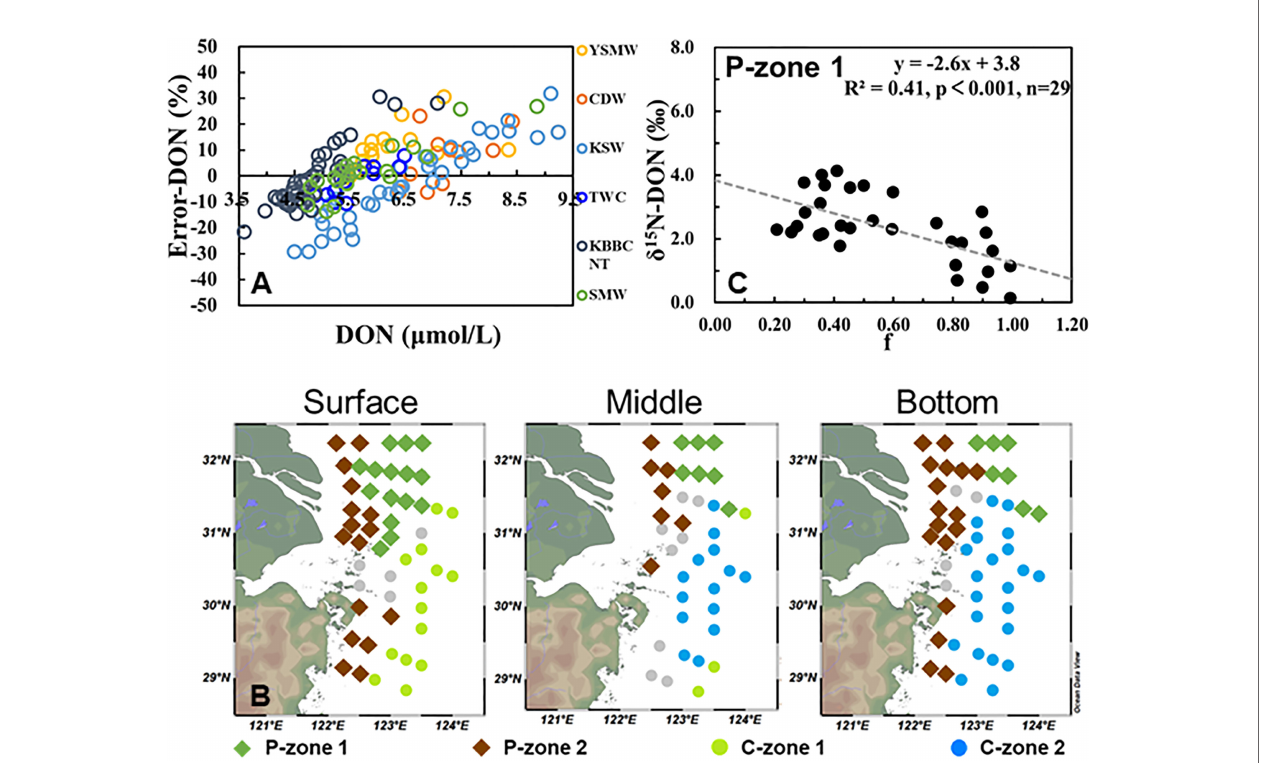
FIGURE 6 | (A) Scatter plots showing the difference (in percentage) between the observed and calculated values of dissolved organic nitrogen (DON) vs. the observed DON concentration. Different colors are used to distinguish stations where Yellow Sea Mixed Water, Changjiang Diluted Water, Taiwan Warm Current, Kuroshio Surface Water, or Kuroshio Bottom Branch Current North of Taiwan dominate by more than 50%. (B) The distributions of DON net production (diamond) and consumption (dot) site zones are noted. (C) Correlation between d 15 N – DON and the fraction of the remaining NO − 3 (marked as